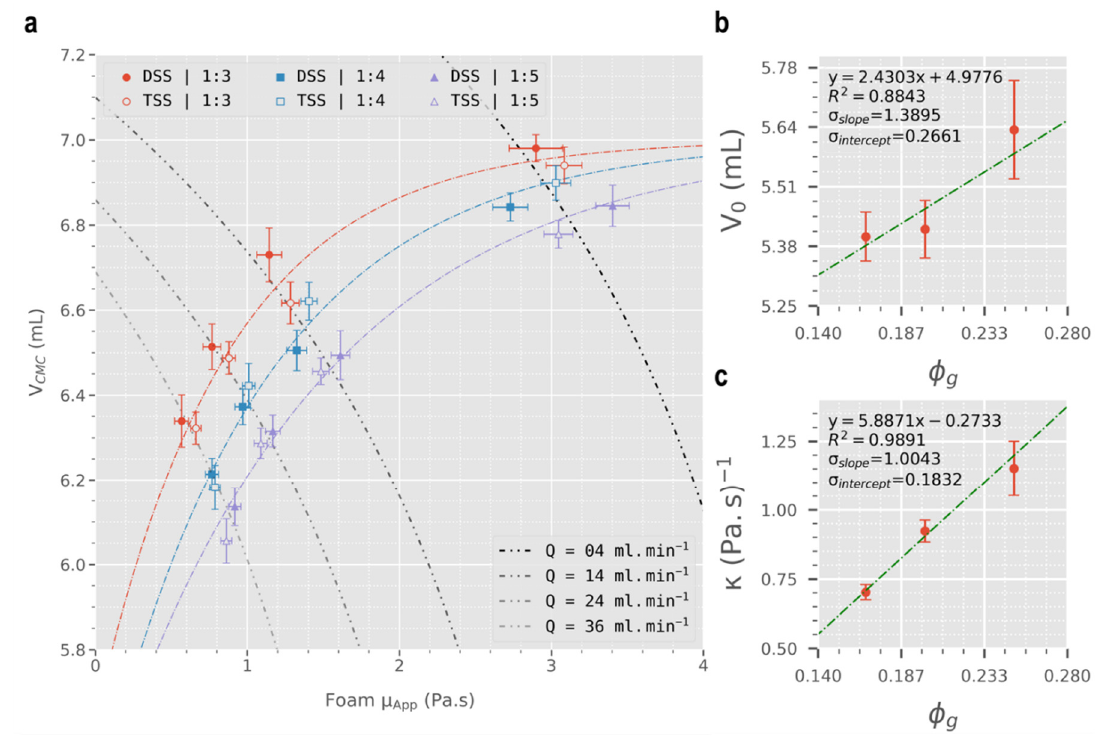
Figure 4. ( a ) Volume of CMC displaced versus foam apparent viscosity ( µ app ). µ app was calculated using power-law indices obtained from the pipe viscometry experiments. Trendlines were obtained through curve fitting into an asymptotic regression model (see Equation (7)). Dotted lines represent flowrate isometric lines. ( b ) Linear regression of V 0 against φ g ( p -value = 0.2210). ( c ) Linear regression of κ against φ g ( p -value = 0.0665).